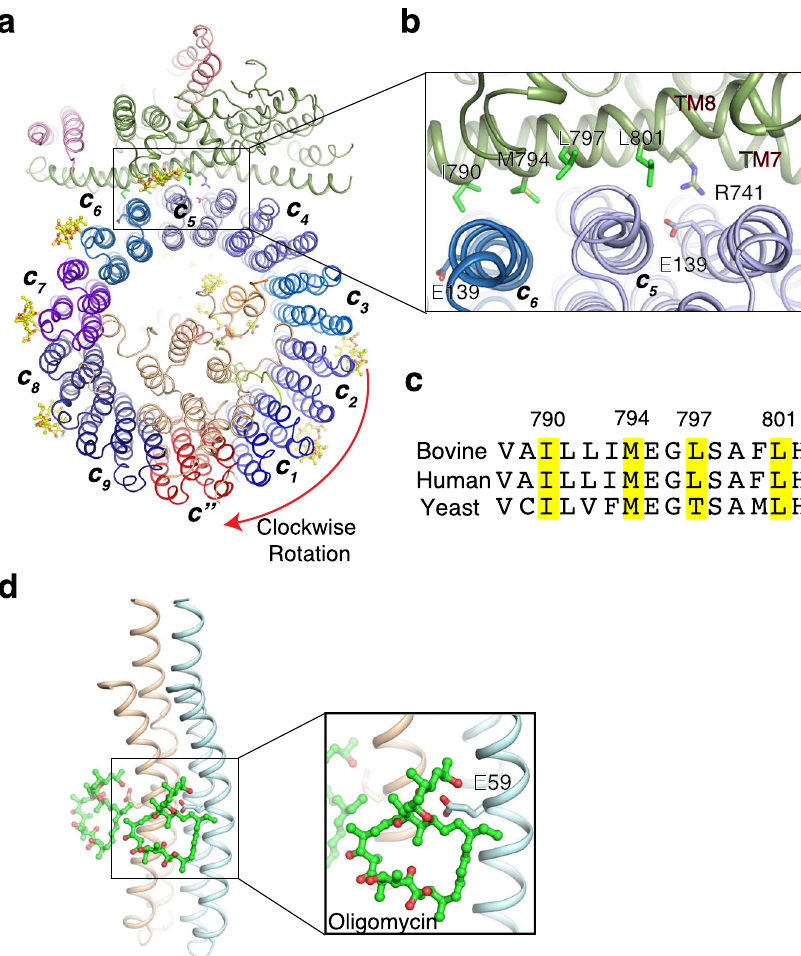
Fig. 4 The mechanism of ba fi lomycin A1 inhibiting rotation of the c-ring. a The rotation model of the c-ring with ba fi lomycin A1 after a 30° rotation. b The residues on TM8 of subunit a would clash with ba fi lomycin A1, preventing rotation of the c-ring. c Sequence alignment between subunit a of different species. The conserved residues for clashing with ba fi lomycin A1 are highlighted in yellow. d Mechanism of oligomycin-mediated F-ATPase inhibition